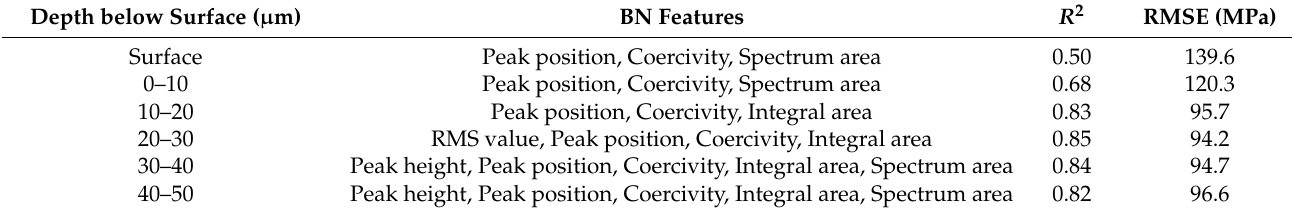
Table 1. Models obtained for estimating averaged residual stresses.